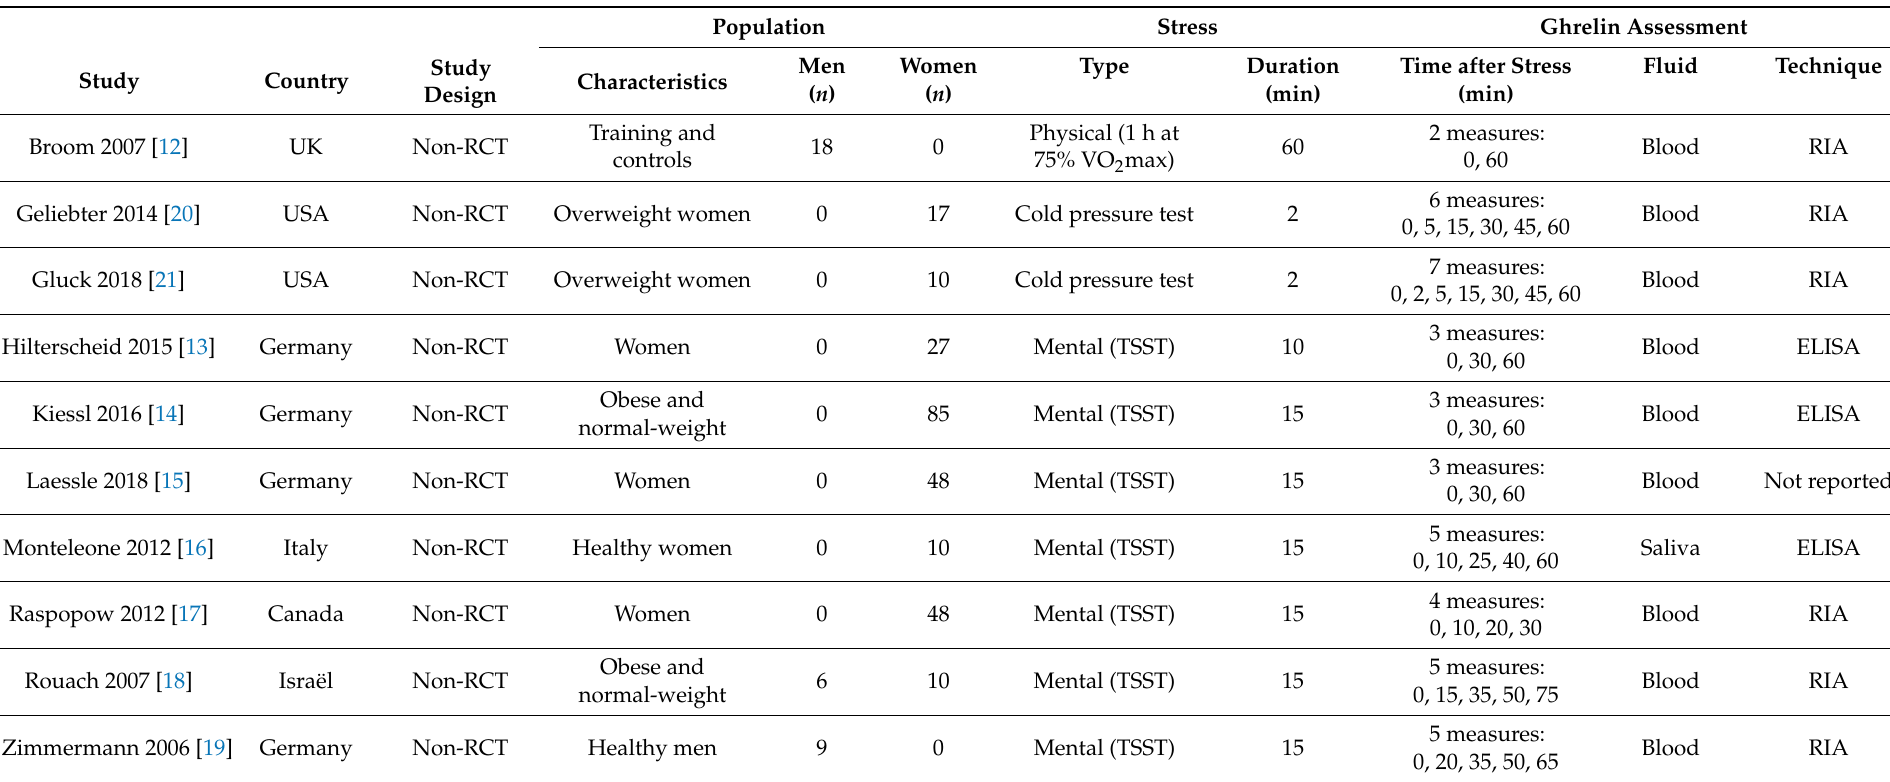
Table 1. Descriptive characteristics of the included studies (all the studies had baseline measures of ghrelin levels, i.e., before